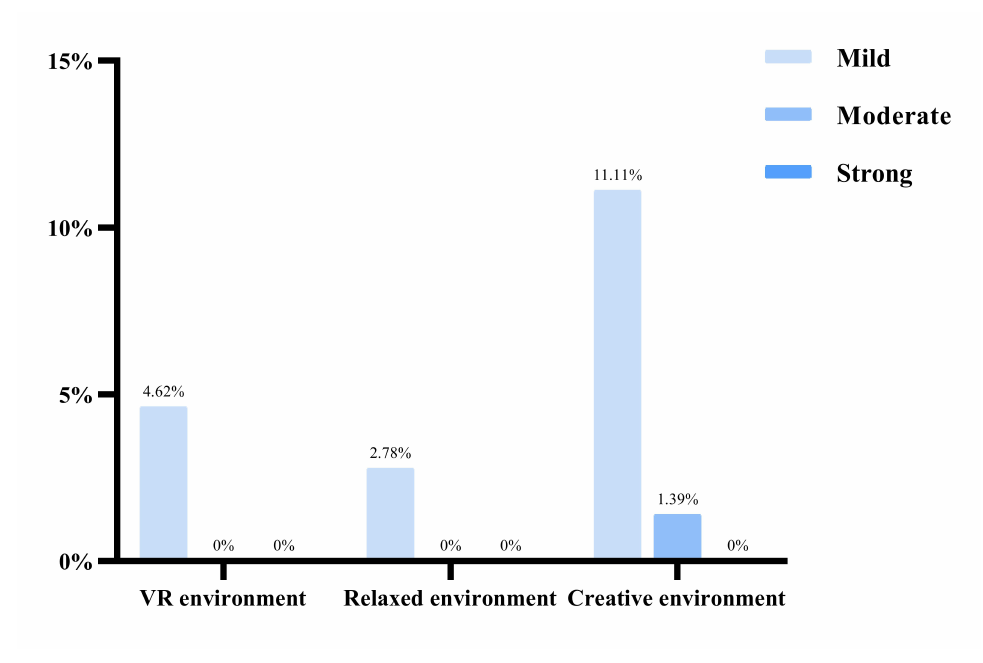
Figure A5. Comparative analysis results of negative affective intensity.